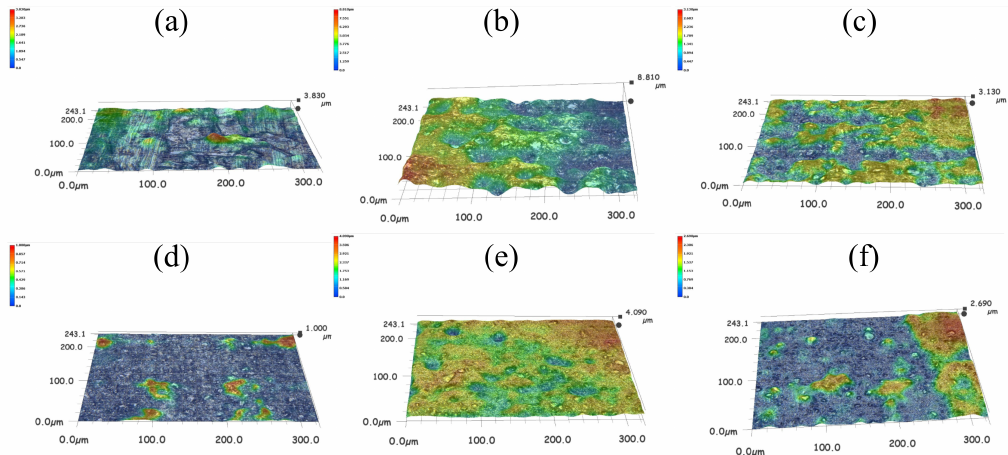
Figure 4. 3D topography of aluminum alloy after laser cleaning under di ff erent powers: ( a ) Reference sample; ( b ) 50 W; ( c ) 88 W; ( d ) 98 W; ( e ) 104 W; ( f ) 110